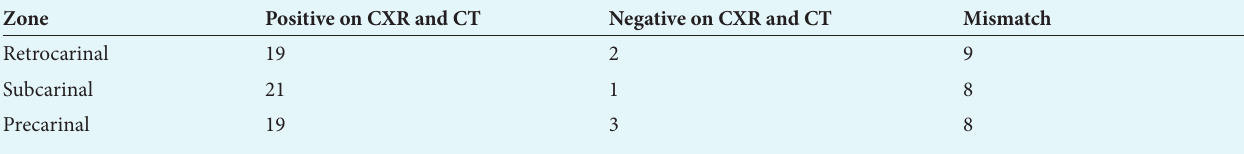
Table 2. Correlation of lateral CXR and sagittal CT reconstruction according to zone in 30 children with PTB